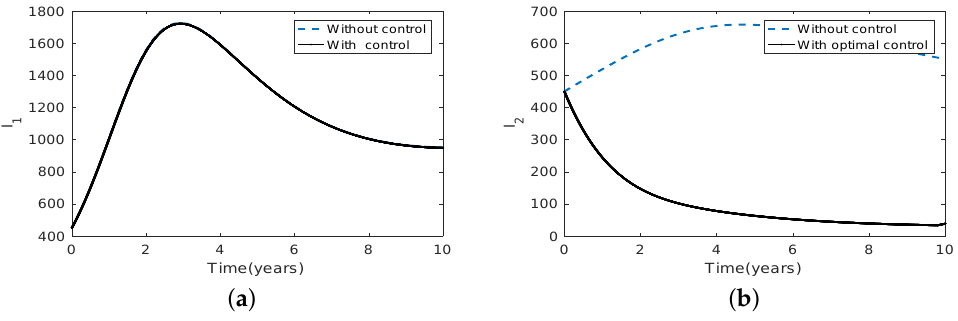
Figure 1. Simulation results of the proposed two patch brucellosis model for scenario 1 under weak symmetric coupling ( a ) the numbers of infected animals in patch 1 ( b ) the numbers of infected animals in patch 2. In all the figures the dotted blue and solid black curves represent the infected population, without and with control,